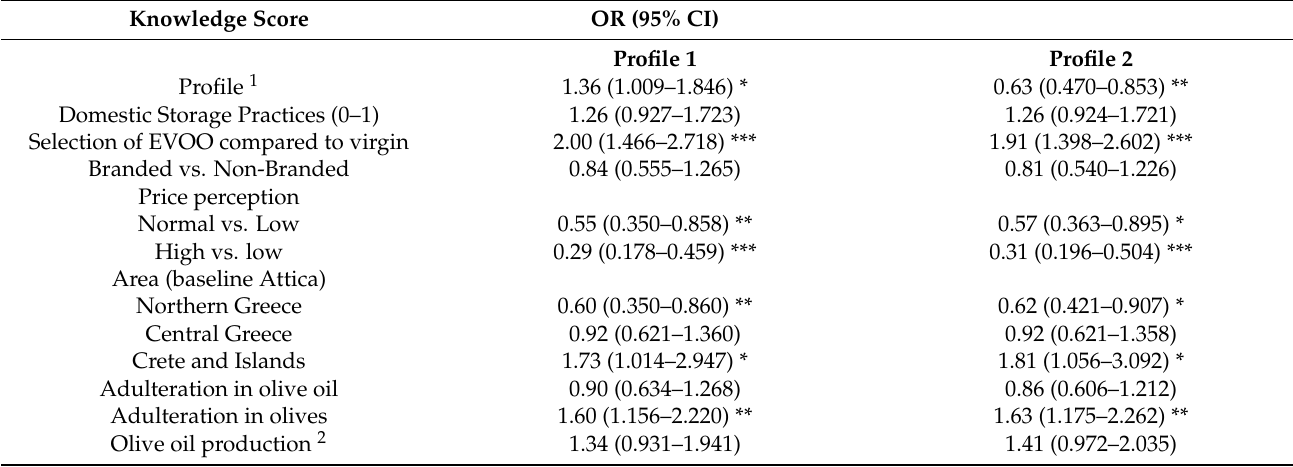
Table 4. Multivariable logistic regression of Consumer Knowledge Score association with the type of oil consumed and domestic storage practices in total and by consumer